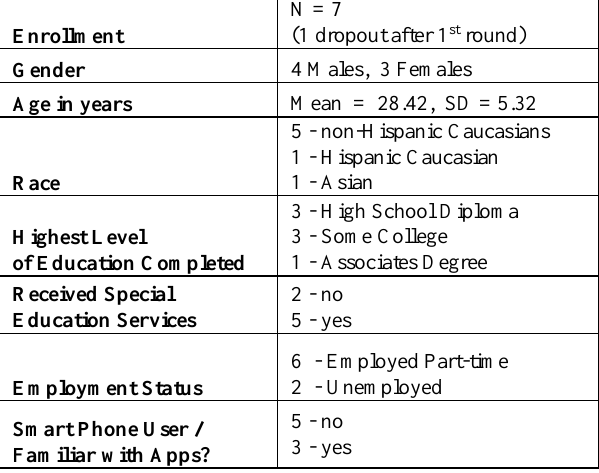
Table 1. Phase I – Participant Demographics